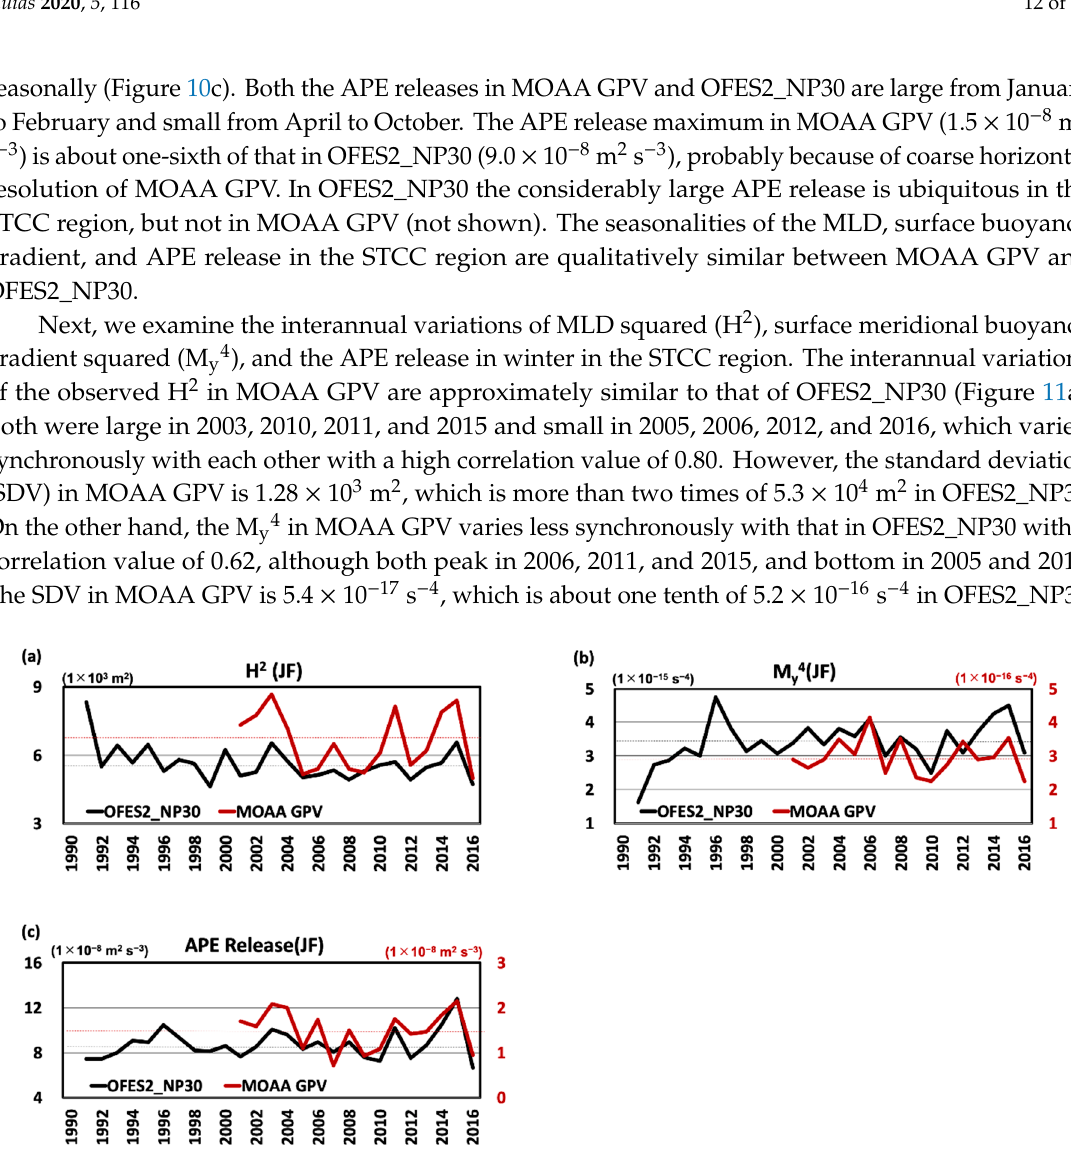
Figure 11. Annual time series of ( a ) MLD squared (H 2 ), ( b ) meridional surface buoyancy gradient squared (M y4 ), and ( c ) parameterized APE release in winter averaged from January to February in the STCC region based on OFES2_NP30 (black curves) and MOAA GPV (red curves).